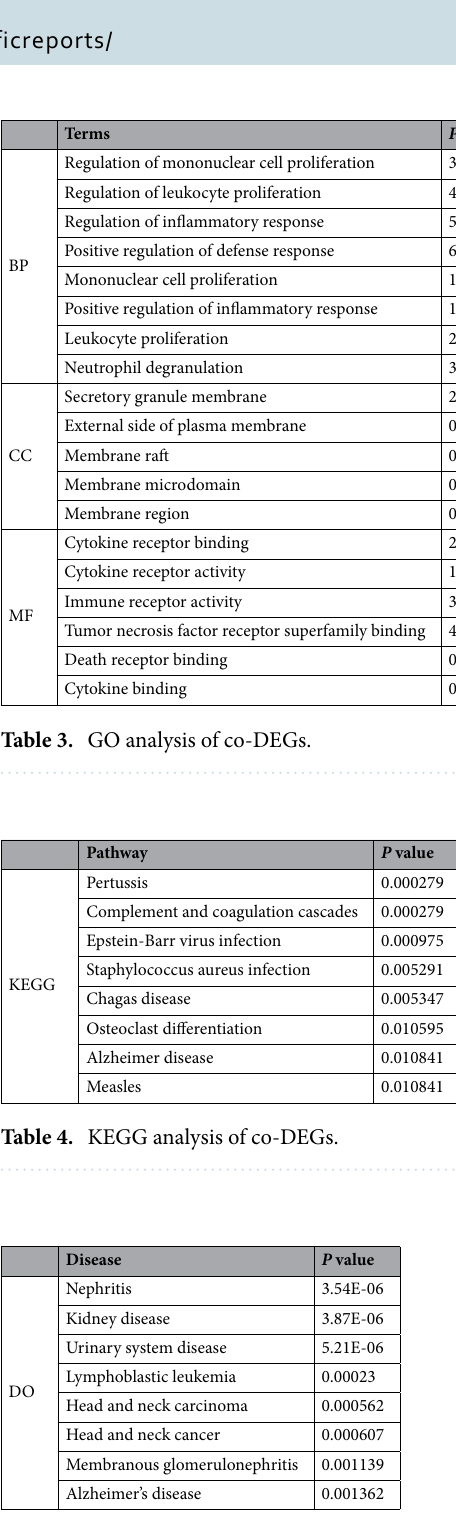
Table 5. DO analysis of